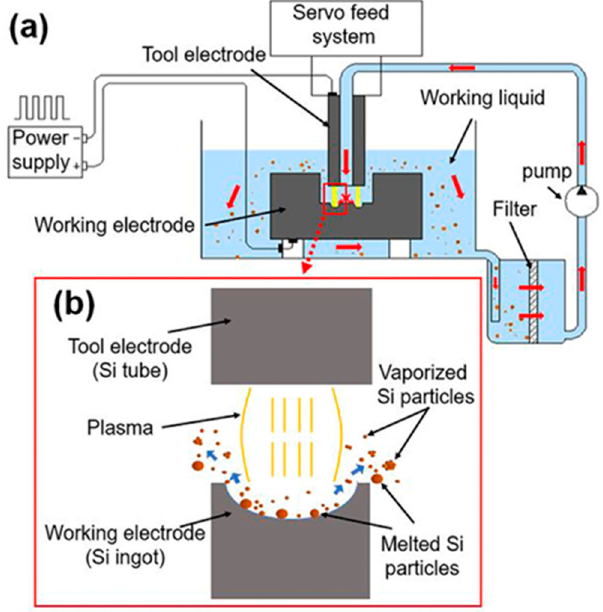
Figure 1. ( a ) Schematic view of spark erosion system and ( b ) illustration of the working area.